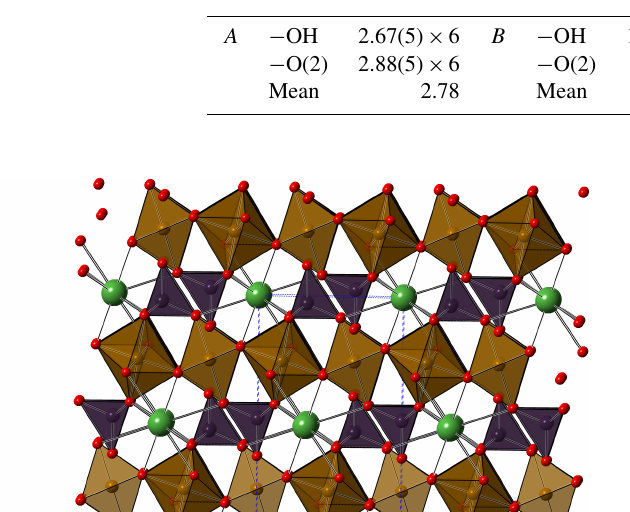
Table 5. Selected bond distances (in Å) for graulichite-(La).